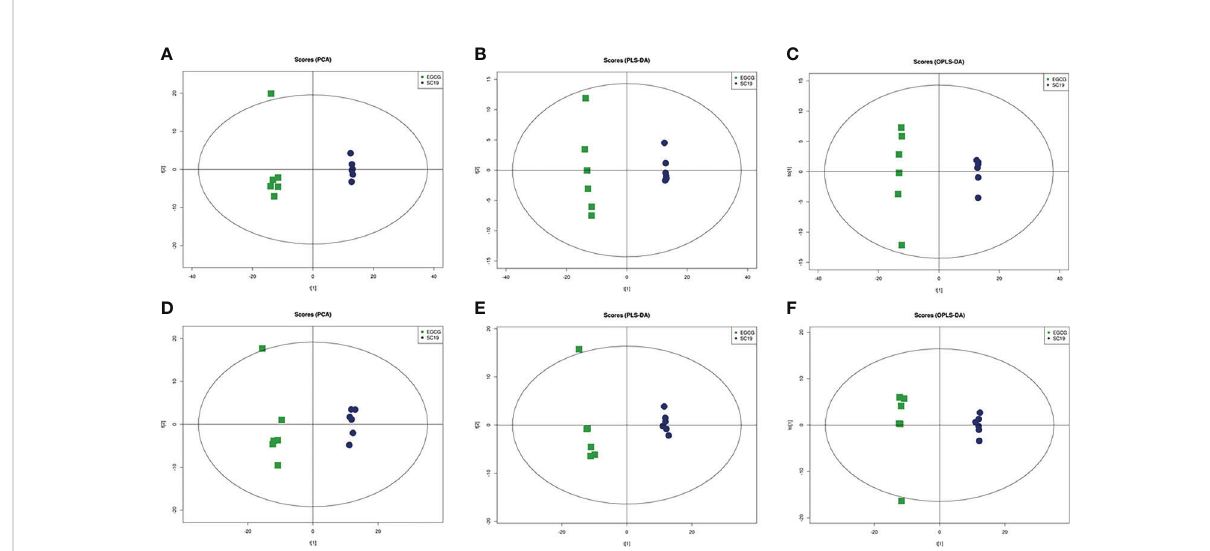
FIGURE 4 Differentiation of the metabolic pro fi les of the SC19 vs EGCG treated SC19 using multivariate analysis. PCA analysis of metabolites under positive (A) and negative (D) ion modes. PLS-DA analysis of metabolites under positive (B) and negative (E) ion modes. OPLS-DA analysis of metabolites under positive (C) and negative (F) ion modes. Spots in blue show samples from the SC19 group, spots in green indicate samples from the EGCG treated SC19 group, there are six replicates per